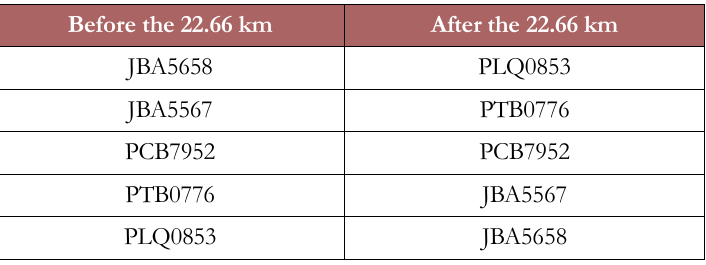
Table 7. Optimal transportation